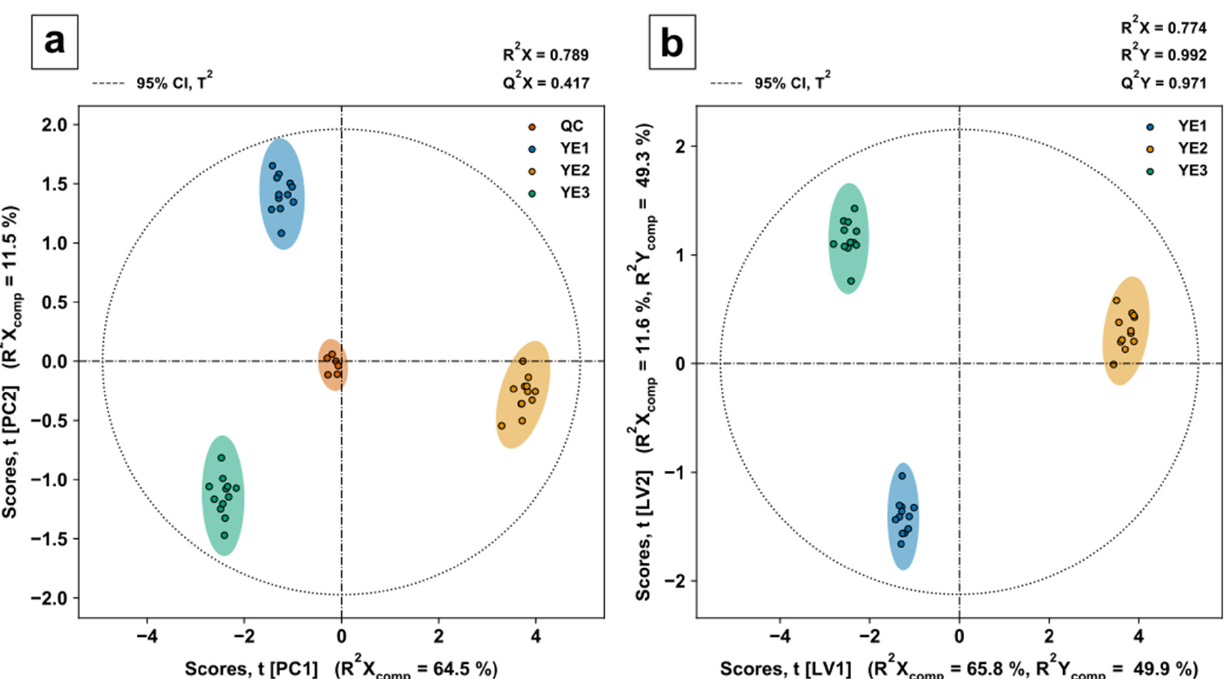
Figure 6. PCA and PLSDA score plots of the first and second PC or LV with Hotelling’s T 2 ellipse for the 95% confidence interval (CI). Model performance indicators were determined by stratified double fivefold cross validation. R 2 X or R 2 X comp describes the goodness of fit or explained variance of the predictor matrix by the model or corresponding PC/LV. ( a ) PCA scores plot for three yeast products (YE1, YE2, YE3) and pooled quality control samples. Q 2 X describes the goodness of prediction. ( b ) PLSDA scores plot for three yeast extract products. R 2 Y or R 2 Y comp describes the goodness of fit or explained variance of the response by the model or corresponding LV. Q 2 Y describes the goodness of prediction for the response.